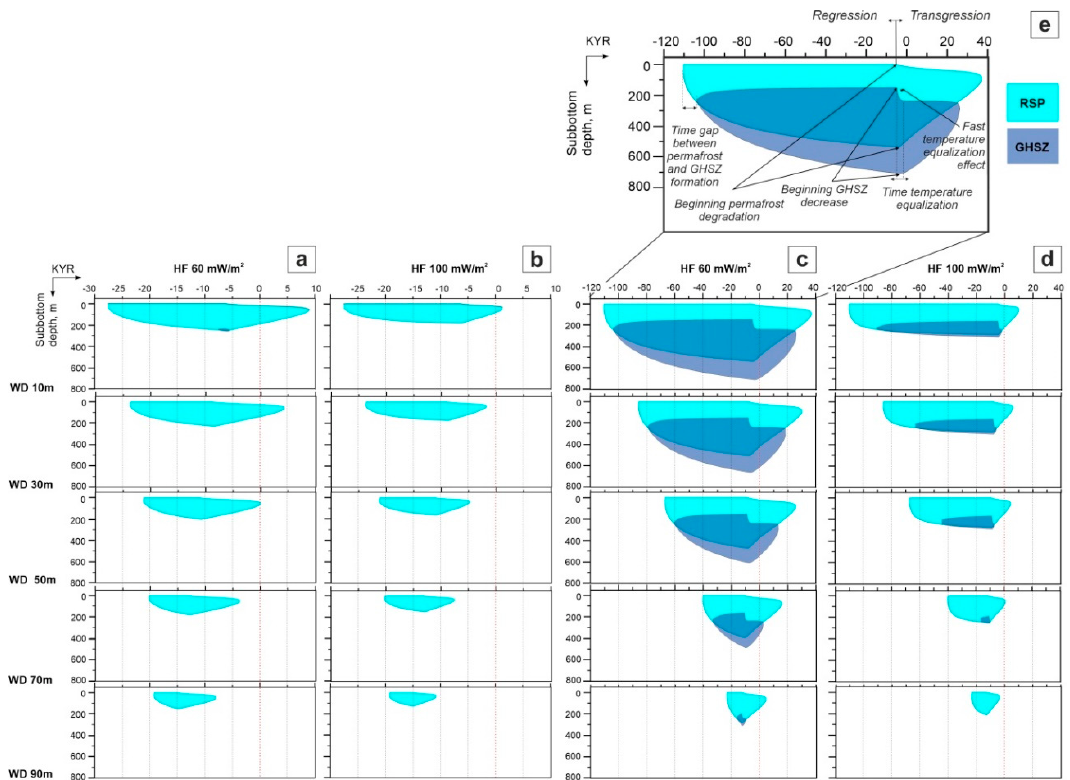
Figure 6. ( a , c ) Forecast of evolution and geometry of the RSP and GHSZ for Scenario 1 and 2 at HF = 60 mW / m 2 ; ( b , d ) at HF = 100 mW / m 2 ; inset explaining the observed changes of RSP and GHSZ geometry in time ( e ). WD—water depth; gas hydrate content = 0%.